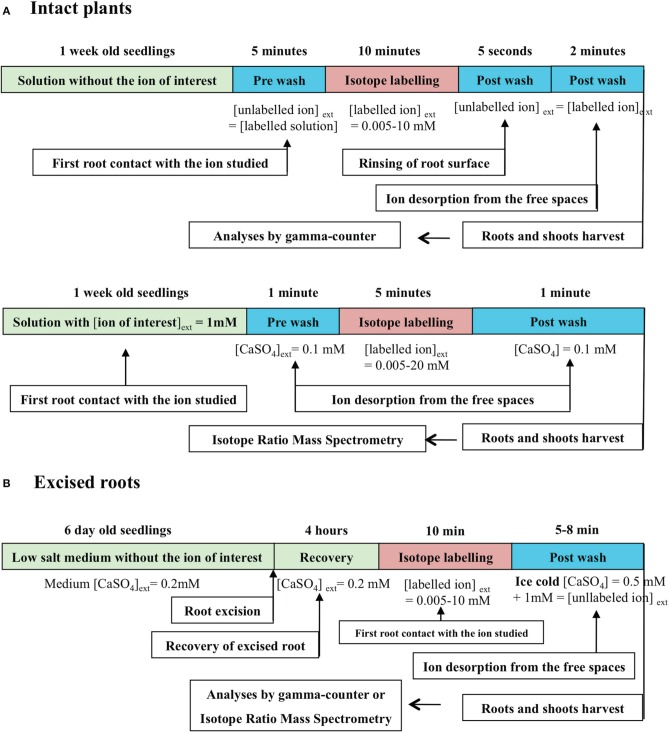
Conventional procedure of ion influx measurements with radioactive or stable ion isotopes by stepwise increase of ion concentrations. (A) Stepwise protocol for nitrate influx isotherms determination in intact plant roots of barley (from Siddiqi et al., 1989, 1990), spruce (Kronzucker et al., 1995a), and Arabidopsis (Filleur et al., 2001). (B) Stepwise protocol for K+ influx isotherms determination of excised roots of 6-day-old dark·grown maize seedlings (from Kochian and Lucas, 1982; Kochian et al., 1985).